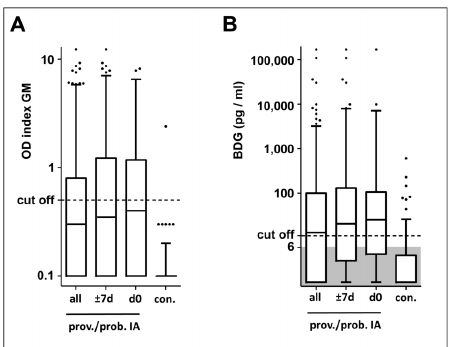
Figure 1. Distribution of GM and BDG measurement results. Three subsets of serum samples of proven / probable IA patients and of an Aspergillus -negative control group were analysed with the galactomannan (GM; ( A )) EIA and the β -1,3-D-glucan (BDG; B) assay. The three subsets of sera of IA patients include (1) all available sera, (2) all sera obtained in the period of ± 7 days from the day of proven / probable diagnosis ( = day 0), and (3) the single serum sampled closest to day 0 of each patient. The optical density indices (A) and the BDG concentrations ( B ) are depicted as box plots. Results below the limit of detection (6 pg / mL) were plotted not to scale in the shaded area. Whiskers mark 5 and 95 percentiles. Dotted lines indicate the applied cut-o ff levels for the individual tests (index of 0.5 for the GM ELISA and a concentration of 11 pg / mL BDG for the BDG assay). OD optical density; d days;